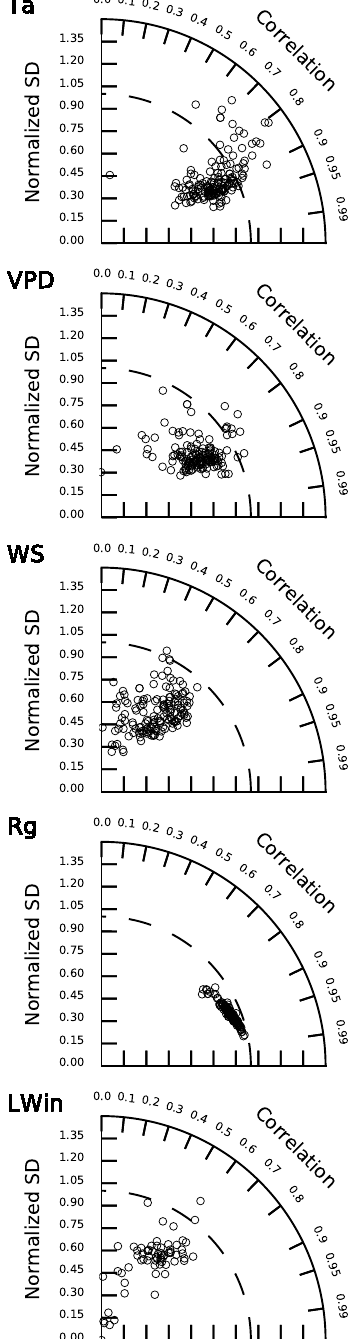
Figure 4. Taylor diagram representing the NSD and correlation ( R ) between the diurnal signals of the ERA-I and FLUXNET product for air temperature, vapour pressure deficit, wind speed, global ra- diation and longwave incoming